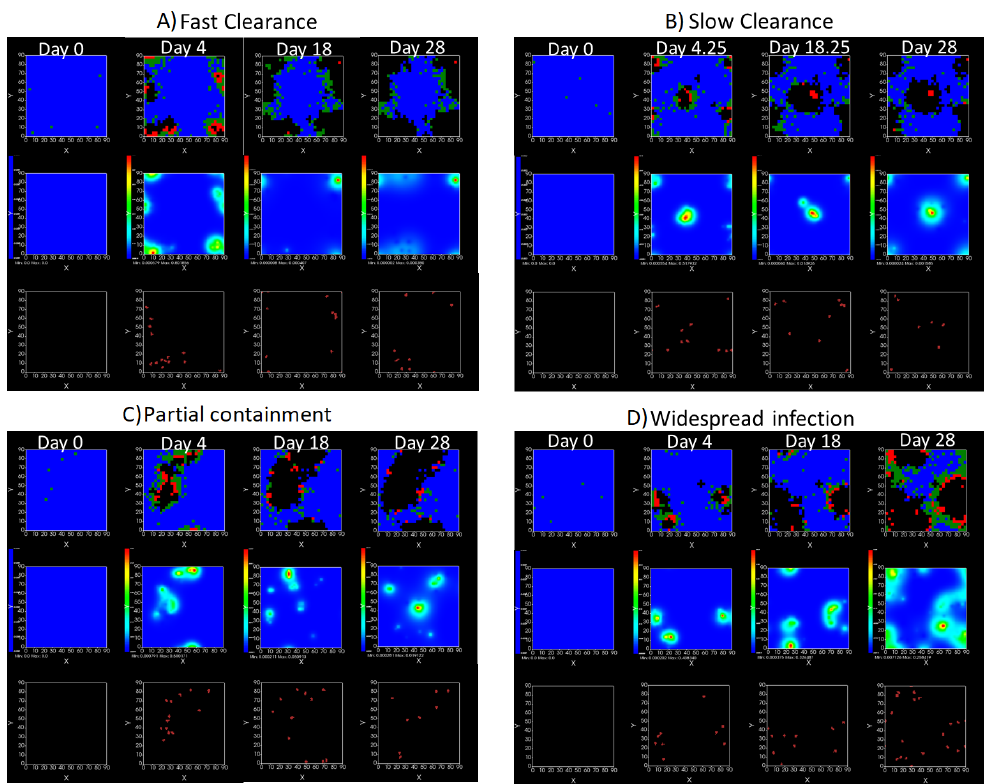
Figure 9. Replica snapshots of the tissue patch are shown for different treatment classifications. In all the cases, the top row is the epithelial layer (blue uninfected cells, green infected cells in eclipse phase, red infected cells releasing virus, black dead cells), the middle row is the extracellular virus concentrations (high concentration in red, low concentration in blue), and the third row is the immune cell layer (immune cells in red, extracellular environment in black). ( A ) Fast clearance (36 h dosing period, 0.01 IC 50 multiplier), ( B ) slow clearance (84 h dosing period, 0.05 IC 50 multiplier), ( C ) partial containment (84 h dosing period, 0.06 IC 50 multiplier), and ( D ) widespread infection (108 h dosing period, 0.07 IC 50 multiplier). In all the cases, snapshots are shown at the start of the simulation (day 0), at the start of treatment (3 days post infection of 10 cells), after 14 days of treatment, and at the end of the simulation (Day